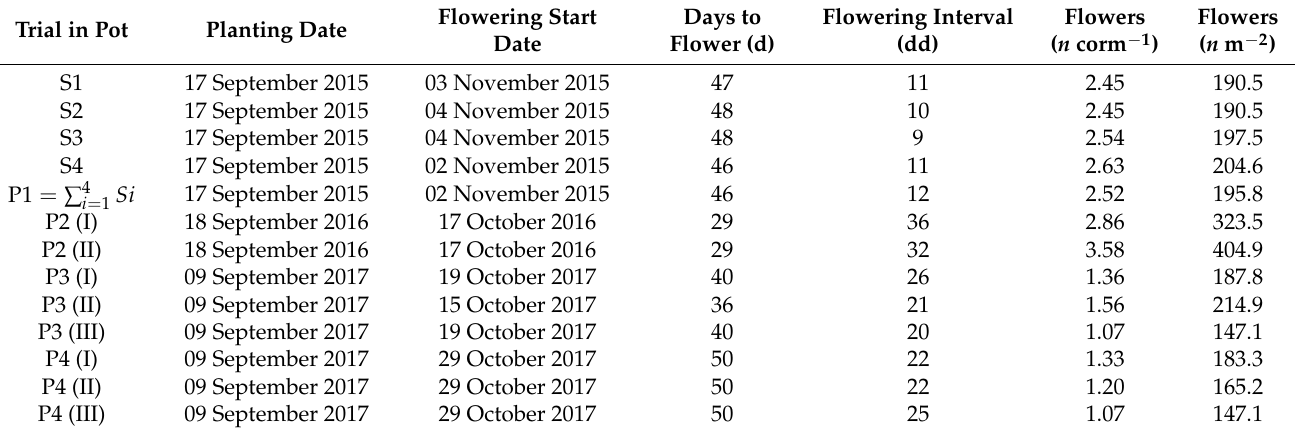
Table 3. Flowering difference between the trials carried out in large pots in the three consecutive Crocus sativus L. growth